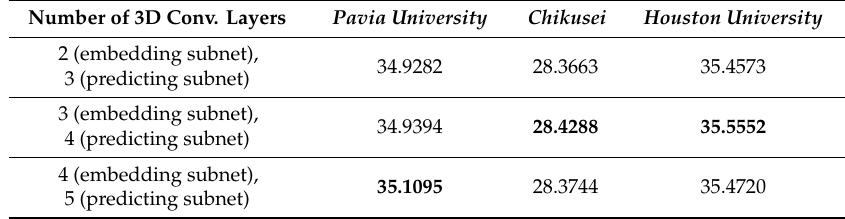
Table 8. PSNR (dB) indices of the sensitivity analysis of MW-3D-CNN over the number of 3D convolutional layers in embedding and predicting subnets. The upscaling factor is two. Number of 3D Conv.